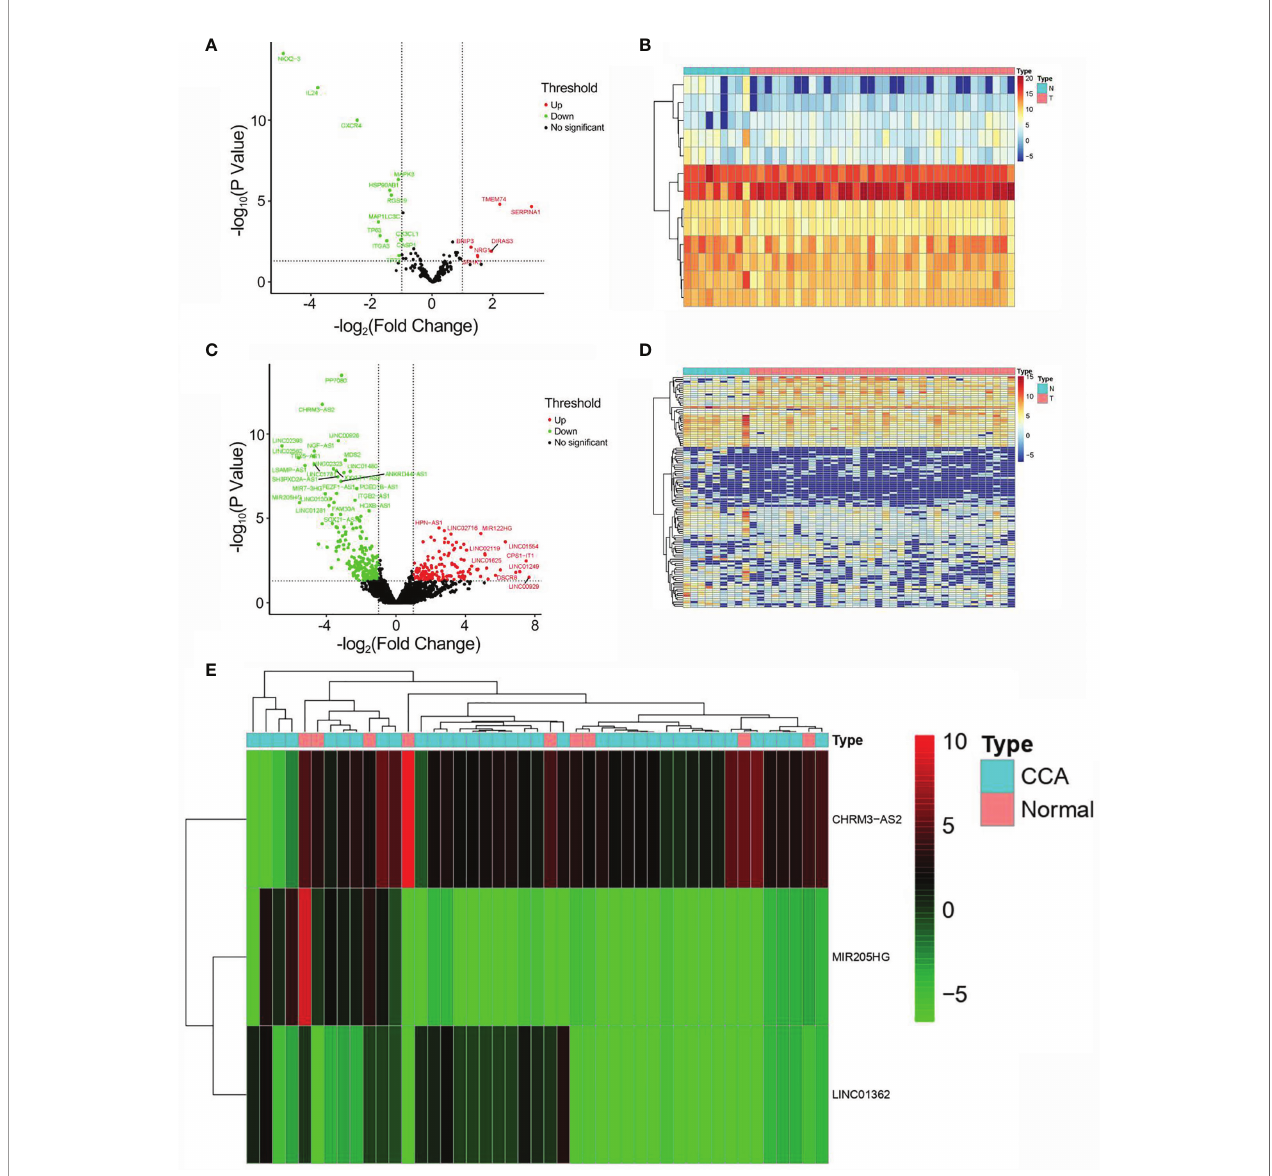
FIGURE 2 | Identi fi cation of DEARGs and DElncRNAs. (A) Volcano plot of DEARG distribution ( n = 13; red dots, upregulated; green dot, downregulated). (B) Heatmap of DEARG expression pro fi les. (C) Volcano plot of DElncRNA distribution ( n = 108; red dots, upregulated ARGs; green dot, downregulated ARGs). (D) Heatmap of DElncRNA expression pro fi les. (E) Heatmap of the expression pro fi les of CHRM3.AS2, MIR205HG, and LINC00661 in CCA patients and normal